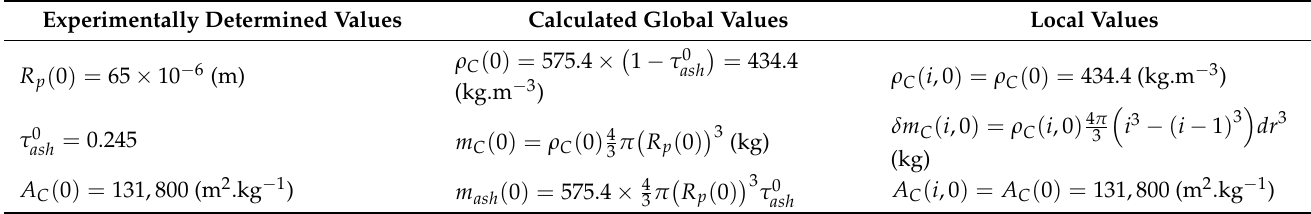
Table 2. Initial values of the parameters involved in the model. Experimentally Determined Values Calculated Global Values Local Values R p ( 0 ) = 65 × 10 − 6